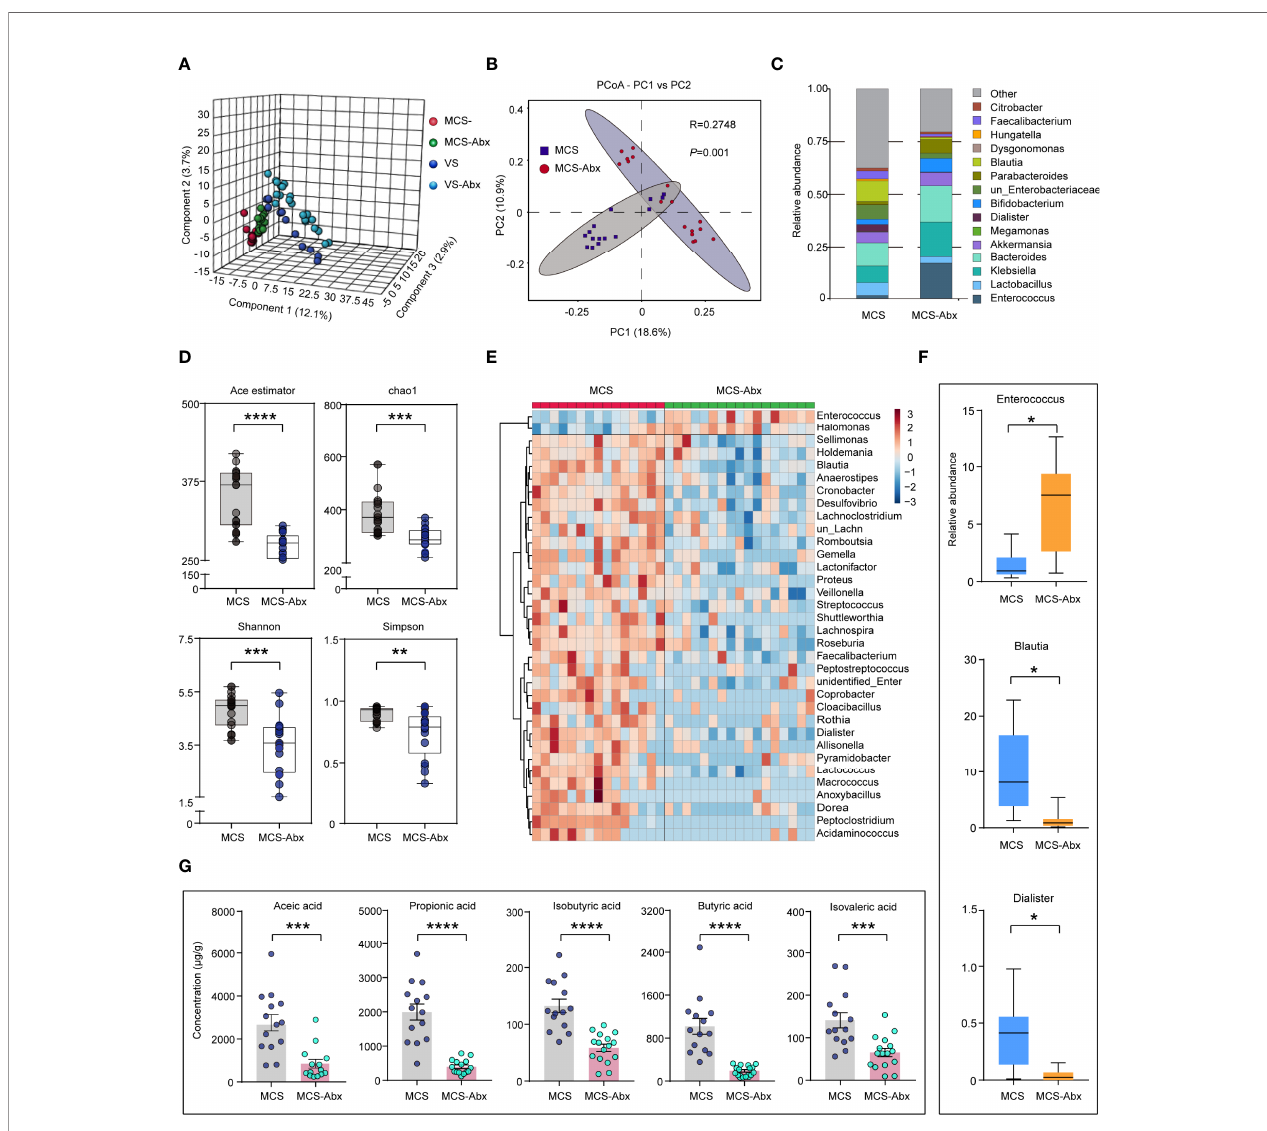
FIGURE 4 | Comparison of the fecal microbial diversity and community structures in MCS patients with or without antibiotic treatment. (A) PLS-DA score plots of the relative abundances of the microbiota in the MCS and MCS-Abx groups and in the VS and VS-Abx groups. Three components explained 18.7% (12.1%, 2.9%, and 3.7%) of the variance among the four groups. Component scores are indicated as percent. Circles indicate individual samples from the four groups. (B) Beta diversity results of the MCS and MCS-Abx groups assessed using principal coordinate analysis (PCoA). A total of 32 samples were used for PCoA. Two principal components (PCs) explained 29.5% (18.6% and 10.9%) of the variance between the groups (Bray – Curtis distance: MCS vs . MCS-Abx: R = 0.2748, p = 0.001). PC scores are indicated as percent. Circles indicate individual samples from the MCS and MCS-Abx groups. (C) Taxonomic distributions of the fecal microbiota at the genus level in the MCS and MCS-Abx groups. (D) The a -diversity of the fecal microbiomes between the MCS and MCS-Abx groups depicted according to ACE, Chao1, Shannon, and Simpson indices. Each box plot represents the median, interquartile range, minimum, and maximum values. (E) Heatmap of the most abundant metabolites in the MCS and MCS-Abx groups, as identi fi ed by the VIP scores in the PLS-DA. Each sample represents a single column. Red indicates the greater abundance of metabolites. (F) Top 3 differential fecal microbiota at the genus level by MetaStat analysis. Each box represents an interquartile range ( fi rst and third quartiles) of taxon abundance, and the middle line corresponds to the median abundance. P -values were corrected using FDR. (G) Comparison of the concentrations of the differential fecal short-chain fatty acids between the MCS and MCS-Abx groups. Data represent the mean ± SEM. P -values were determined using Student ’ s t -test or the Kruskal – Wallis test and were corrected using FDR. * p < 0.05, ** p < 0.01, *** p < 0.001, **** p < 0.0001; n.s. , no signi fi cant difference. MCS , minimally conscious state; VS , vegetative state; Abx , antibiotic; PLS-DA , partial least squares discriminant analysis; VIP , variable importance in projection; FDR , false discovery